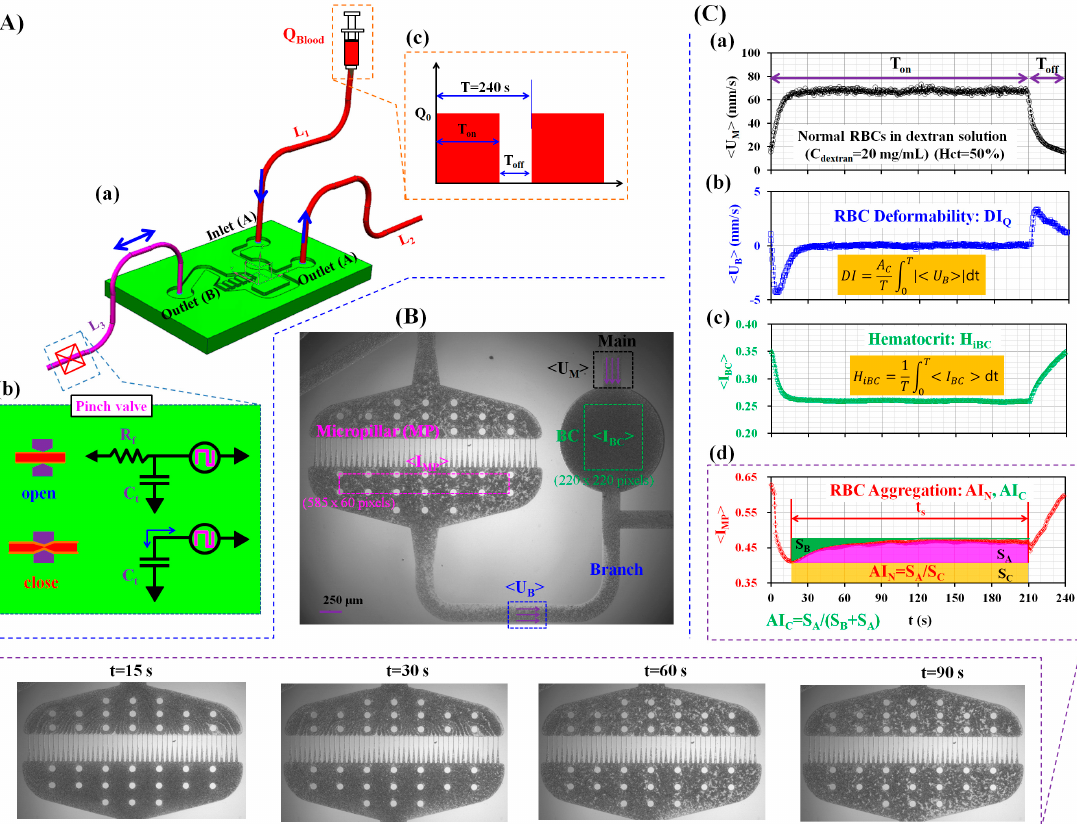
Figure 1. A proposed method for quantifying biophysical properties, including RBC (red blood cell) deformability, RBC aggregation, and hematocrit. ( A ) A schematic diagram of the proposed method, including a single syringe pump, a disposable microfluidic device, and a pinch valve. ( a ) The microfluidic device is composed of an inlet ( A ), two outlets ( A , B ), a big-sized channel (BC), a parallel micropillar (MP), a branch channel, and a main channel. Three polyethylene tubes (L 1 , L 2 , and L 3 ) are connected to the inlet ( A ), and two outlets ( A , B ). ( b ) To induce back-and-forth blood flow in the MP, a pinch valve is employed to clamp a polyethylene tube connected to the outlet ( B ). Due to the tube compliance, blood flow is periodically oscillated depending on the blood flow-rate that is supplied from the syringe pump. ( c ) Blood flow-rate is set to a periodic on–off profile (i.e., amplitude of blood flow-rate = Q 0 , turn-on time = T on , turn-off time = T off , and period = T). ( B ) A high-speed camera triggered by a function generator is used at an interval of 0.5 s to consecutively capture two microscopic images at a frame rate of 5 kHz. Two averaged intensities (<I MP >, and <I BC >) and two averaged velocities (<U B >, and <U M >) are obtained by conducting digital image processing and a time-resolved micro-PIV technique, respectively. ( C ) As a preliminary demonstration, the hematocrit of blood was adjusted to 50% by adding normal RBCs into a dextran solution of C dextran = 20 mg/mL. Blood was supplied into the inlet ( A ) at a periodic on–off profile (i.e., Q 0 = 1 mL/h, T on = 210 s, T off = 30 s, and T = 240 s). ( a ) Temporal variations of the averaged blood velocity in main channel (<U M >) over a single period. ( b ) Temporal variations of the averaged blood velocity in the branch channel (<U B >) over a single period. DI is suggested to quantify RBC deformability. ( c ) Temporal variations of the averaged image intensity (<I BC >) in BC over a single period. H iBC is proposed to quantify the hematocrit variations in the BC. ( d ) Temporal variations of the averaged image intensity (<I MP >) in the MP over a single period. AI N and AI C are adopted to evaluate the RBC aggregation. Sequential microscopic images depicted RBC aggregation in the MP with respect to time (t) (t = 15 s, 30 s, 60 s, and 90